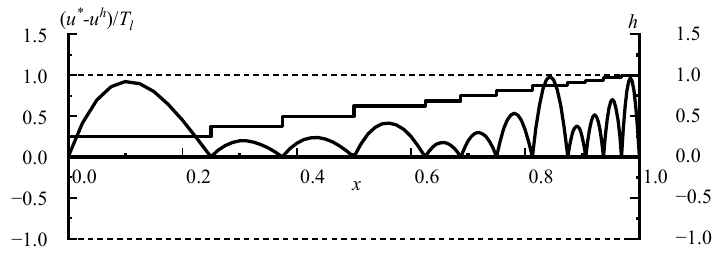
Figure 11. Mesh π ∗ and distribution of error ( u ∗ − u h ) / T Figure 11. Mesh * π and distribution of error